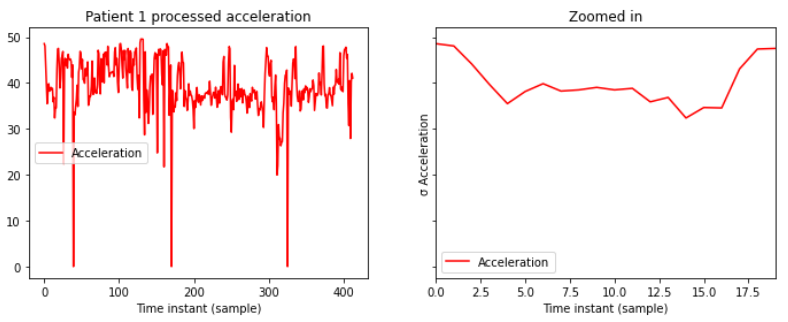
Figure 3. Patient 1 processed acceleration